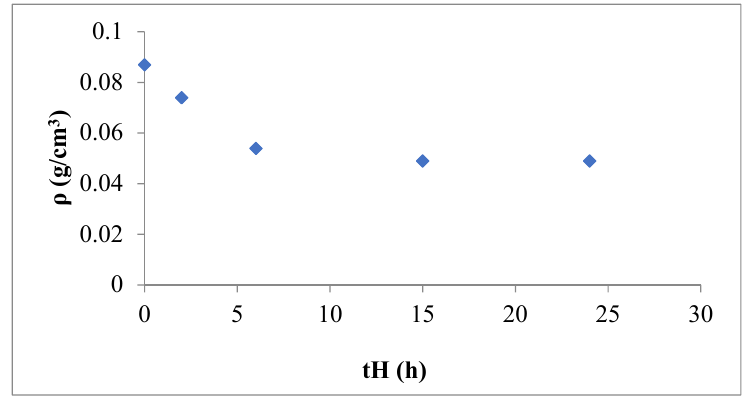
Figure 6. Apparent density vs time of the hydrothermal treatment.